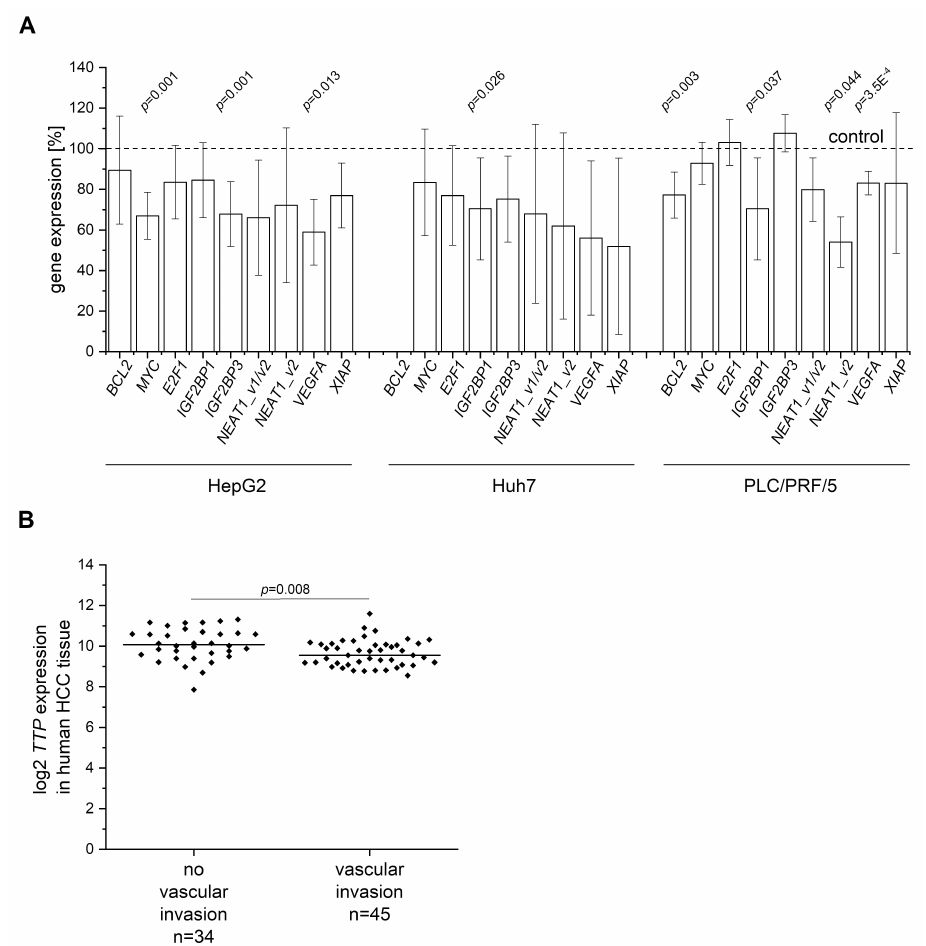
Figure 6. Oncogene expression in TTP-overexpressing hepatoma cells. ( A ) Expression levels normalized to cells treated with a control vector were determined in HepG2, Huh7, and PLC / PRF / 5 cells by qPCR. BCL2 was not determined in Huh7 cells since mRNA expression was below the detection limit. n = 2; triplicates. ( B ): TTP (gene name ZFP36 ) expression in human hepatocellular carcinoma (HCC) grouped into tumors positive ( n = 45) or negative ( n = 34) regarding vascular invasion (GSE20238).